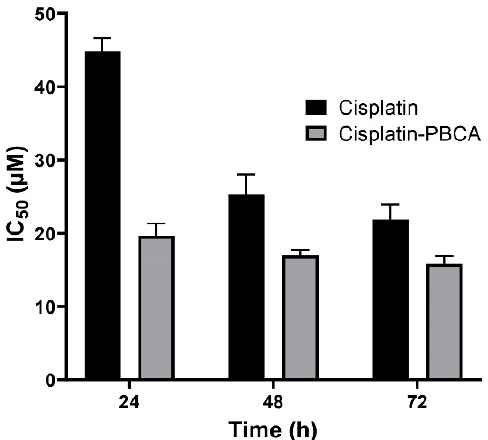
Figure 5. Cytotoxicity effects (IC 50 ) of cisplatin-loaded PBCA nanoparticles (19.2 ± 0.41, 17 ± 0.9 and 15 ± 0.27 µM after 24-, 48- and 72-h incubation, respectively) compared to the standard drug (44.4 ± 1.9, 26 ± 0.83, and 20.3 ± 0.22 µM after 24-, 48-, and 72-h incubation, respectively) against human renal adenocarcinoma (ACHN). The data were expressed as mean ± SD (n = 3).